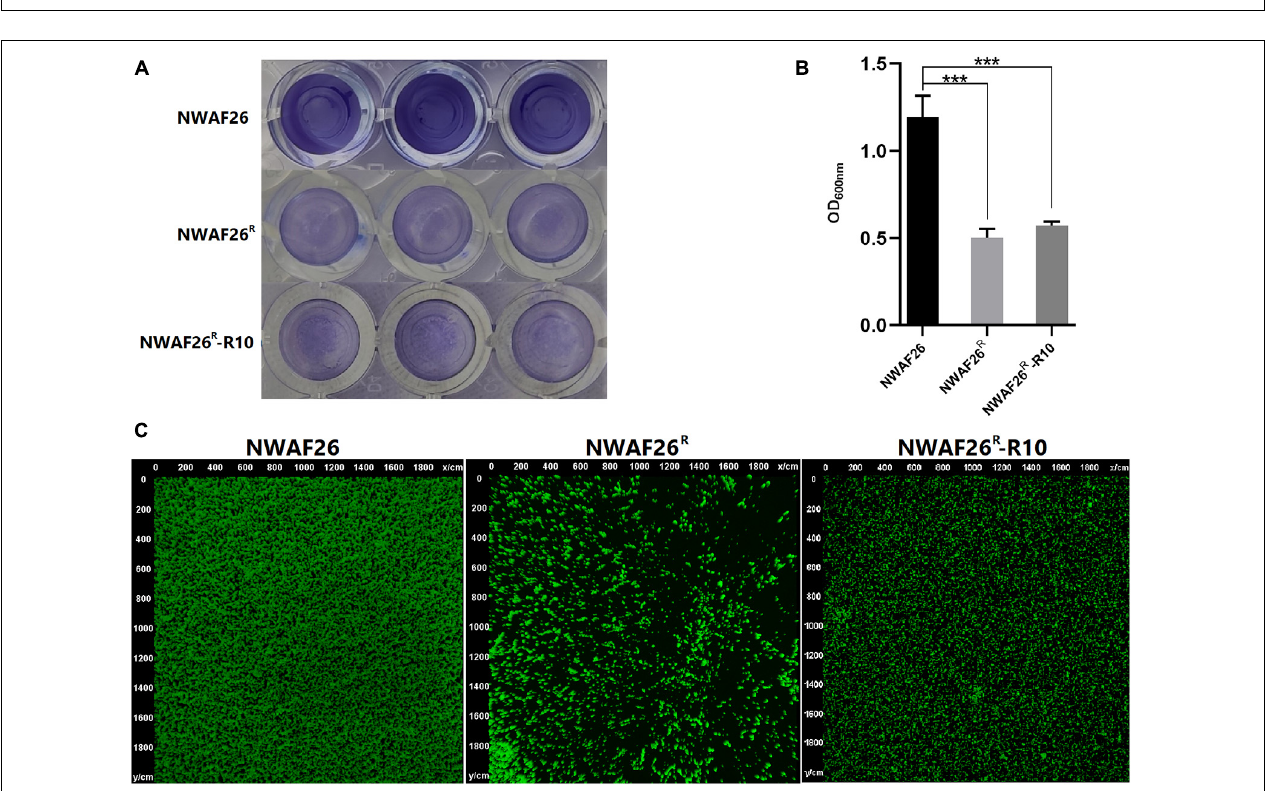
FIGURE 6 | The biofilm thicknesses of NWAF26 and its derivations were determined by crystal violet staining (A,B) and CLSM (C) . The crystal violet staining was conducted by cultivating the S. scirui in 96-well plates at 37 ◦ C to the stationary phase, and staining with 0.5% crystal violet after being washed. The biofilm quantitation was determined by solubilizing the stained biofilms with 30% glacial acetic acid, and quantitated by measuring the OD 600 . *** p <